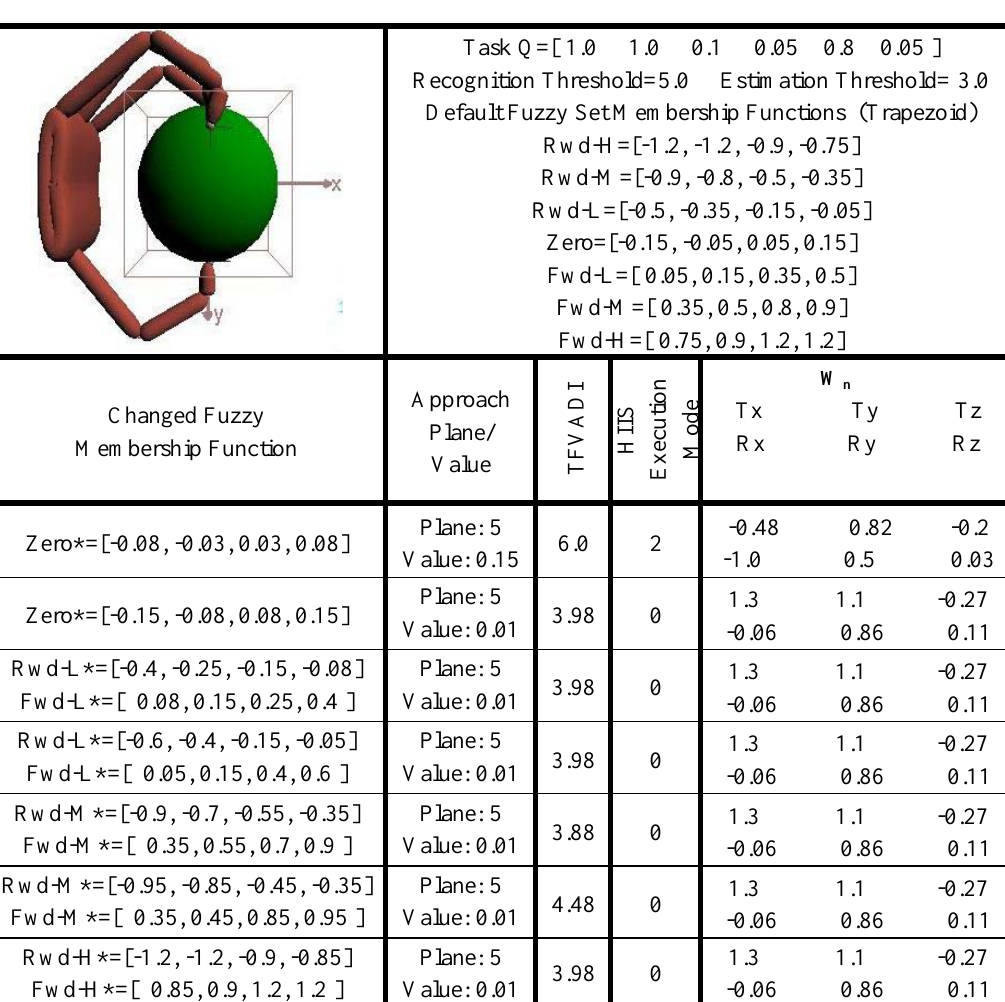
Figure 16 Sensitivity to Variations in Fuzzy Membership